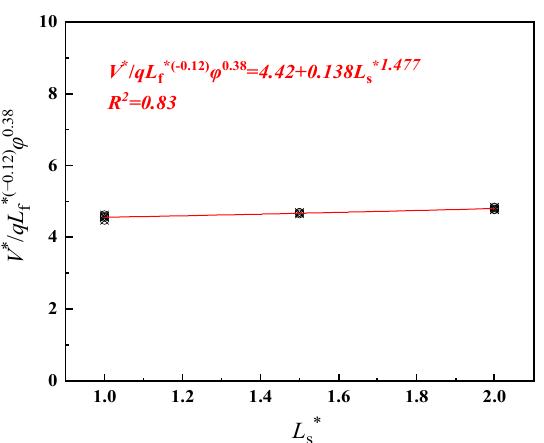
Figure 11. Dimensionless relation between inlet air velocity and shaft height ( L f ≤ 330 m).